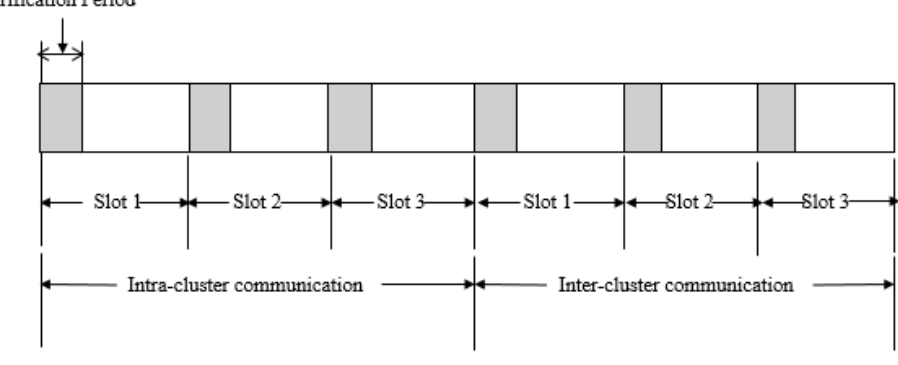
Figure 4. Verification Periods in a Frame.